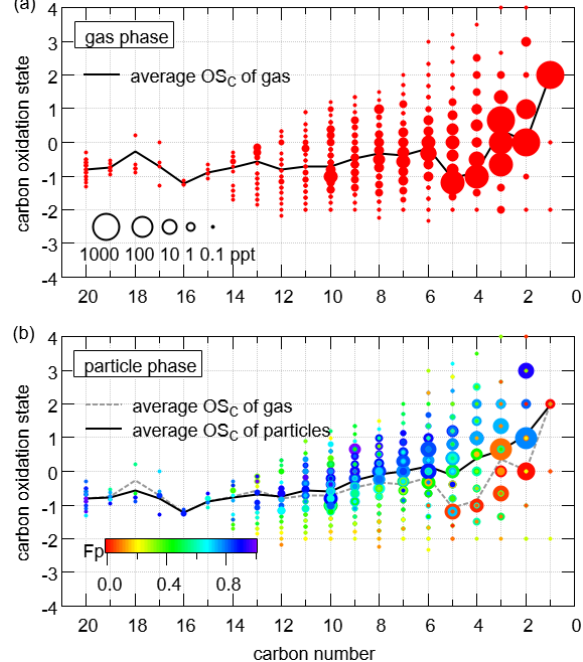
Figure 12. OS C − n C spaces for C x H y O z and C x H y N 1 , 2 O z com- pounds in the gas phase (a) and the particle phase (b) . The diame- ters of circles are proportional to the logarithmic average concentra- tions. The black lines are the average OS C of each carbon number for compounds in the gas phase and the particle phase, respectively. The compounds in panel (b) are color-coded by their fractions in